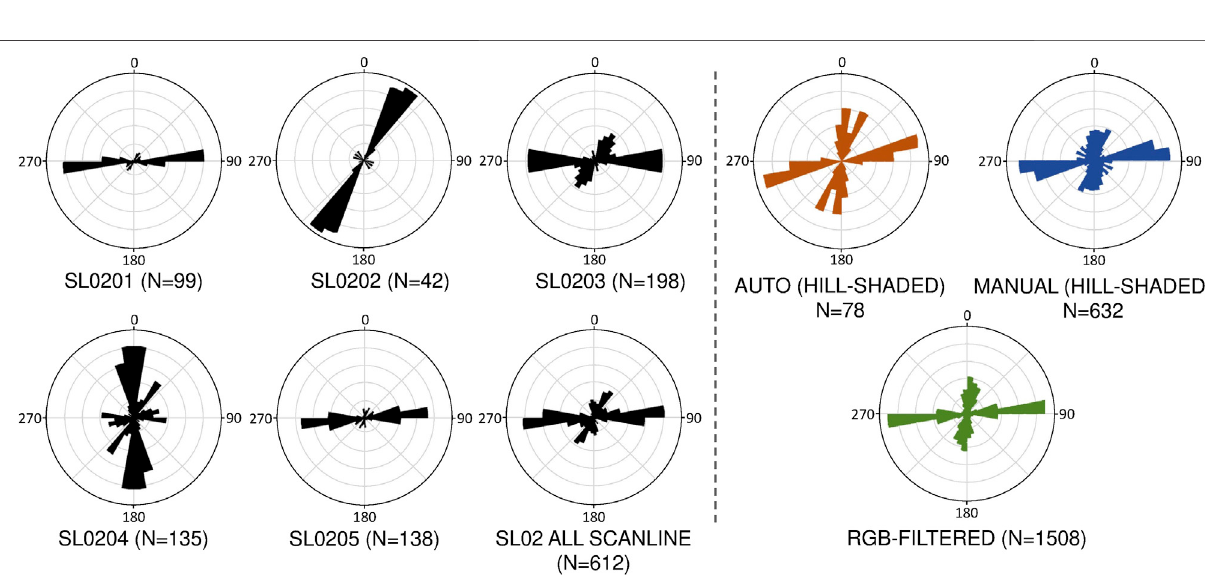
Frontiers in Earth Science |